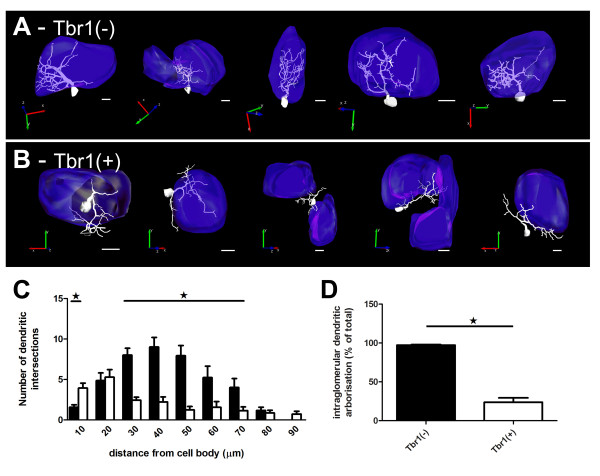
Tbr1 immunoreactivity distinguishes short axon cells from surrounding tufted juxtaglomerular interneurons. (A,B) Neurolucida reconstruction of individual Neurog2-derived juxtaglomerular neurons and of the associated glomeruli that are negative (A) or positive (B) for Tbr1. A three-dimensional drawing of individual glomeruli is shown in blue. (C) Sholl analysis of the two populations of cells reveals a tufted arborization of the Tbr1-negative population of juxtaglomerular cells. (D) Quantification of the percentage of intrabulbar dendritic arborization. Note the very pronounced differences observed between the two cell populations, with Tbr1-negative juxtaglomerular neurons showing intraglomerular extending dendrites while Tbr1-positive neurons show preferential periglomerular dendrites. Scale bars: 20 μm in (A); 15 μm in (B-E); 10 μm in (F,G). Error bars indicate S.E.M.; *P < 0.05, determined by unpaired t-test.